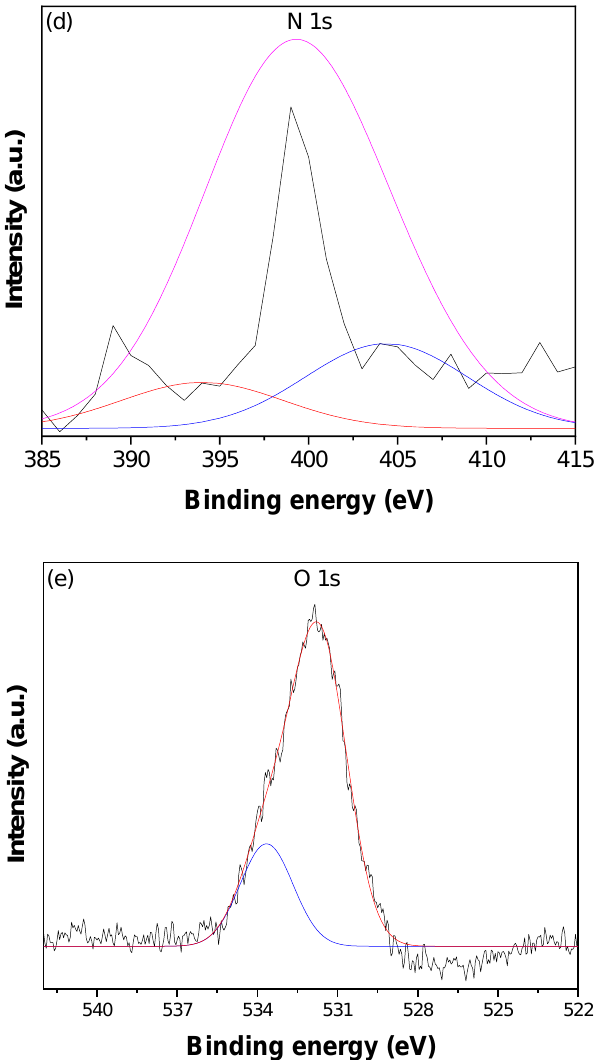
Figure 4. ( a ) XPS survey spectrum, ( b ) high-resolution spectrum of C1s, ( c ) high-resolution spectrum of Ag3d, ( d ) high-resolution spectrum of N 1s, and ( e ) high-resolution spectrum of O1s of CNTs–